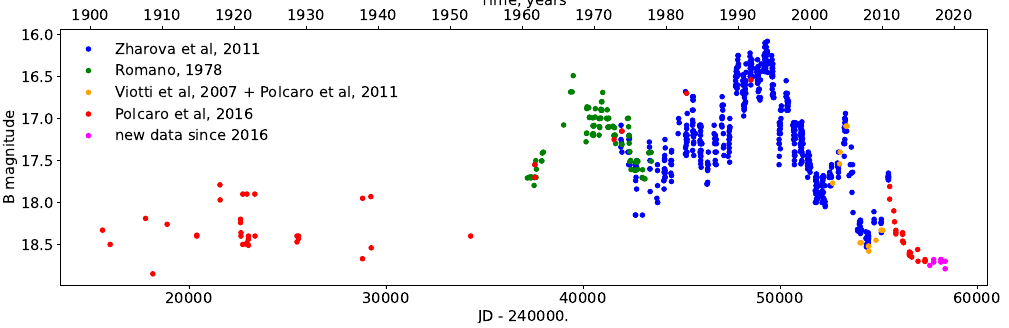
Figure 2. The historical light curve of GR290 in the B-filter from 1901 to